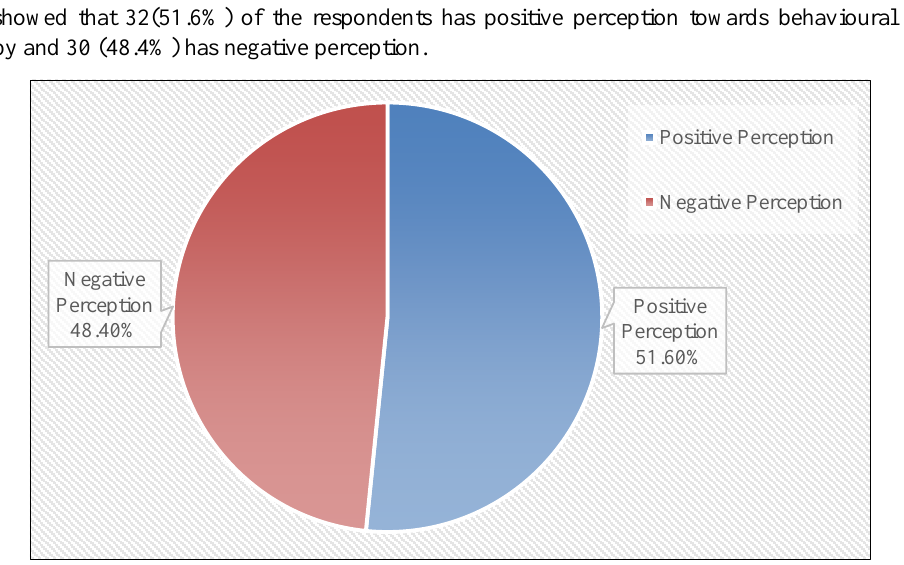
Figure 2. Patients’ perceptions of compliance to dialysis therapy